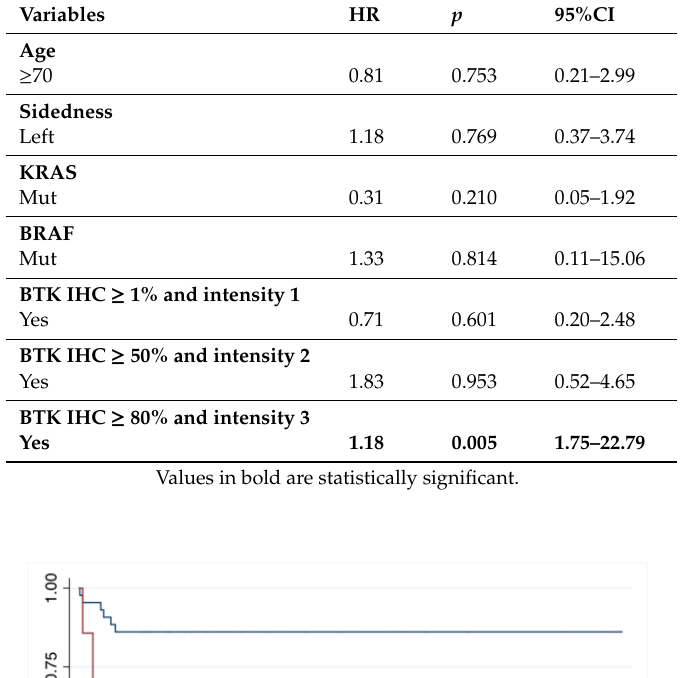
Table 4. Univariate analysis of disease-free survival (DFS).